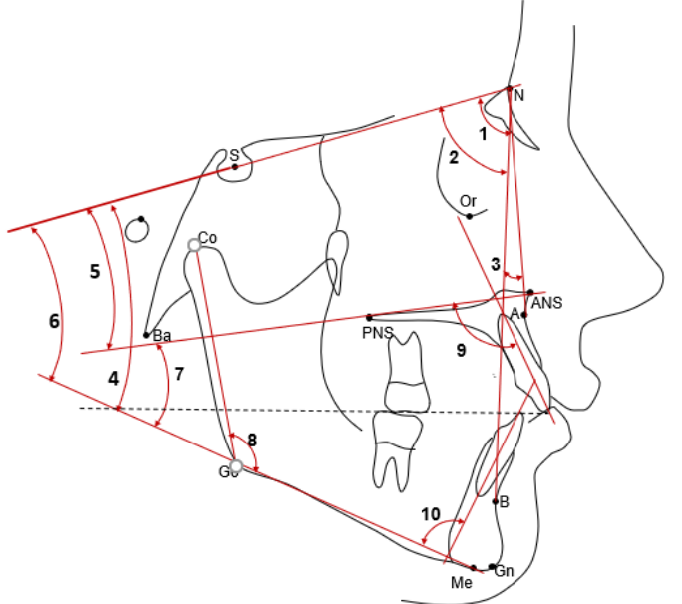
Figure 2. Cephalometric landmarks and angular measurements. Cephalometric landmarks: S, Sella; N, Nasion; ANS, Anterior Nasal Spine; PNS, Posterior Nasal Spine; A, A point; B, B point; Gn, Gnathion; Me, Menton; Go, Gonion; Co, Condylion. Cephalometric angular measurements: (1) SNA; (2) SNB; (3) ANB; (4) SN to occlusal plane; (5) SN to palatal plane; (6) SN to mandibular plane; (7) palatal plane to mandibular plane; (8) Co-Go-Me mandibular angle; (9) upper incisor to palatal plane; (10) lower incisor to mandibular plane.